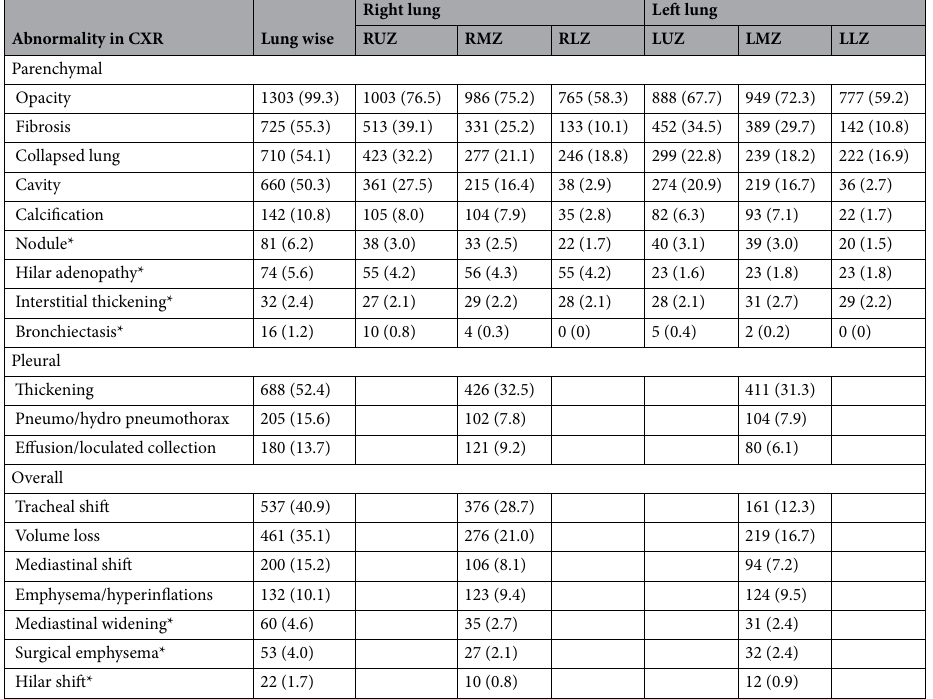
Table 1. Distribution of radiological abnormalities—lung wise and zone wise representation used in the model. RUZ right upper zone, RMZ right mid zone, RLZ right lower zone, LUZ left upper zone, LMZ left mid zone, LLZ left lower zone. *< 10% distribution and hence excluded from model development. All values represented n (%) format.